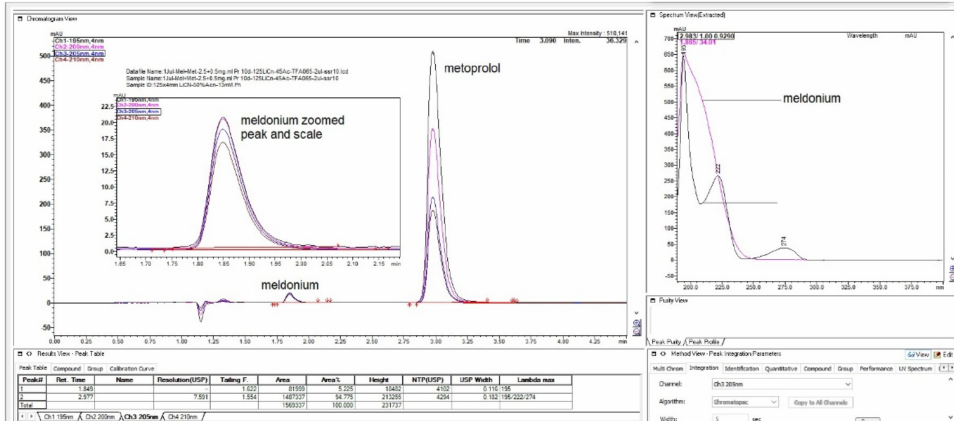
Figure 7. Chromatogram with LiChrospher CN125 × 4 mm with 45% ACN and 55% TFA 0.065 %, visible good retentions of meldonium, quite small peak and quite smaller peak height increasing with the decreasing wavelength in the lowest UV-range. While the baseline was remarkably different, changes in meldonium peak size were quite small, and very big to the peak of metoprolol. Other visible change was meldonium UV-abs spectrum shape, while the metoprolol UV-spectrum was